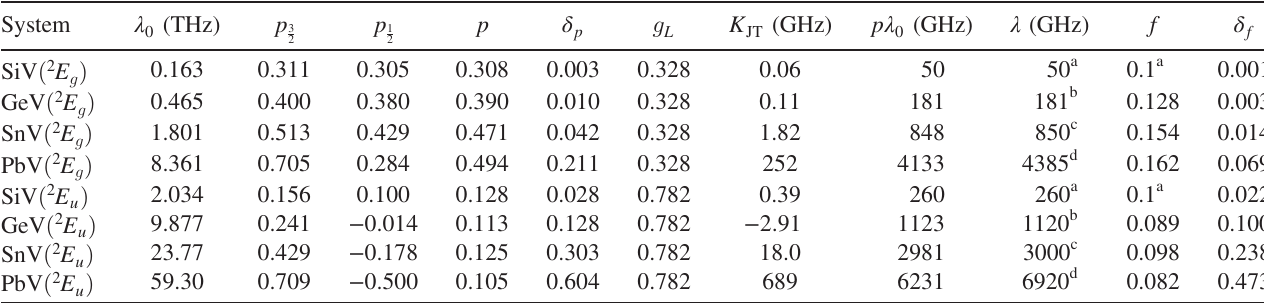
TABLE IV. Proposed parameters of the effective Hamiltonian in Eq. (9) for X V ð − Þ systems. λ 0 is scaled to reproduce the experimental λ for SiV ð − Þ , GeV ð − Þ , and SnV ð − Þ . The p , δ reduction parameters are calculated ab initio from the SOC and DJT coupled p Hamiltonian (see Fig. 5 for visual interpretation). The orbital g reduction factors were fit to reproduce the experimental curves for L SiV ð − Þ , and the same g factors were applied to the other X V ð − Þ systems. The definition of the parameters shown here can be found in L Eqs. (C8) –